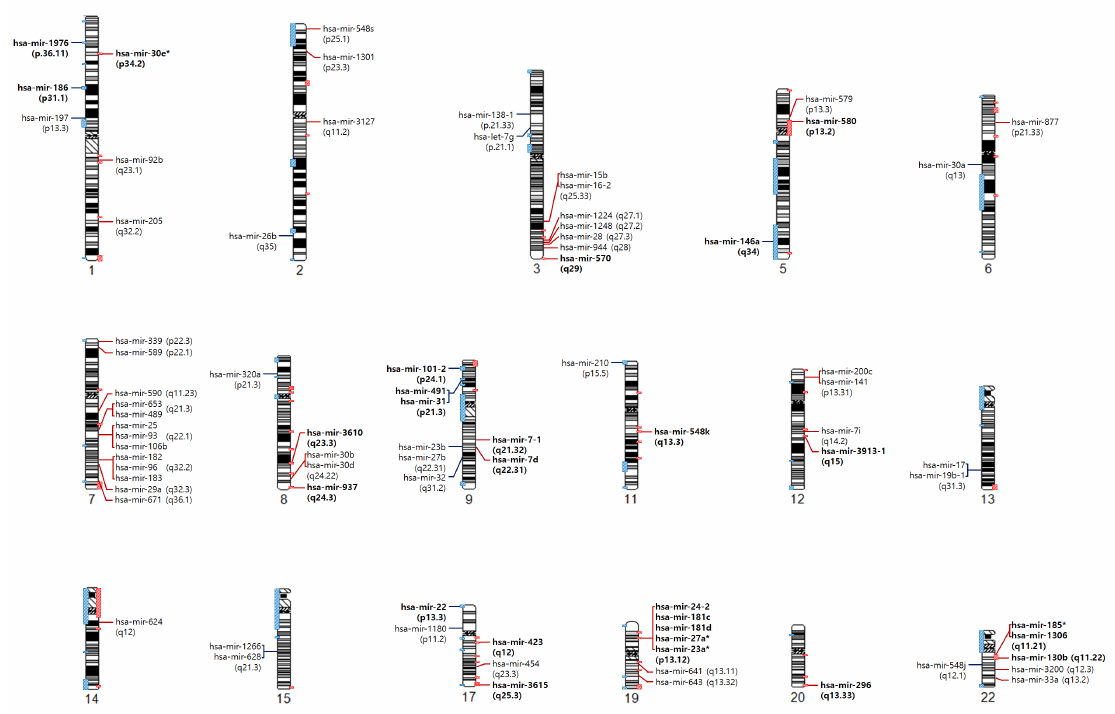
Figure 4. Chromosome ideogram obtained by mapping SCNA-miRNAs and pan-cancer SCNA regions. Pan-cancer SCNA regions, amplified (red) or deleted (blue), are shown for each chromosome, and the locations of the SCNA-miRNAs are indicated with cytogenetic bands. The 26 miRNAs in the pan-cancer SCNA regions are represented in bold, and the remaining 54 miRNAs are shown together, which are located within 10.6 mega bases (Mbs) of pan-cancer SCNA regions on average (ranging from 0.3 to 47.4